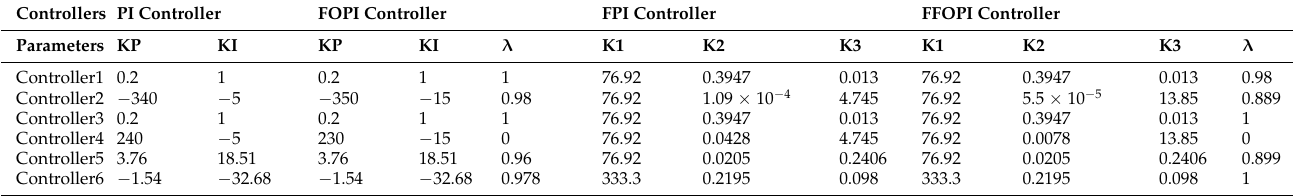
Table 5. Controller gains of microgrid system M 2 for PI, FOPI, FPI, and FFOPI controllers.